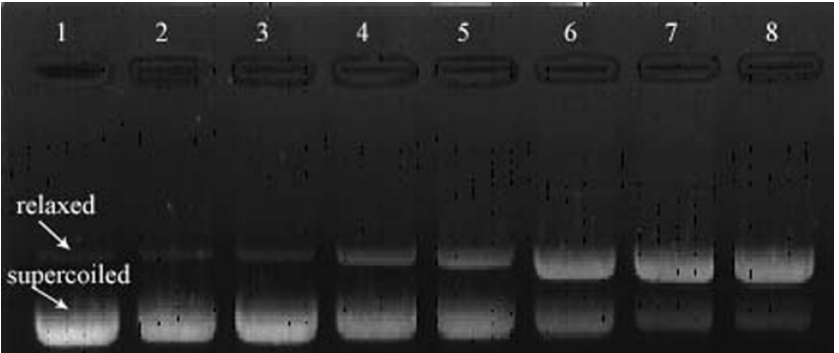
Figure 5. Agarose gel electrophoretic patterns of plasmid DNA treated with curcumin in the presence of Cu (II) ions (0.2 mM). pBR322 plasmid DNA (0.5 µg) was incubated for 1 h at 37 ºC in the presence of the following additives: lane 1, no addition (DNA control); lane 2, 0.2 mM curcumin without copper; lane 3, copper without curcumin; lanes 4–8, copper plus curcumin at different concentrations, 0.01, 0.025, 0.05, 0.1, and 0.2 mM,